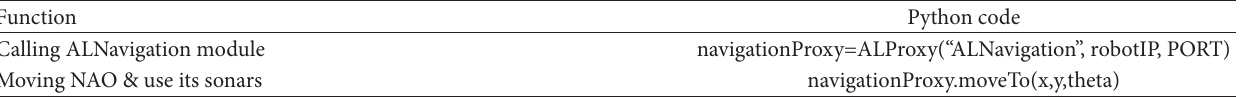
Figure 7: The overall flow chart of the navigation. Table 2: Main python code for using obstacle avoidance function.